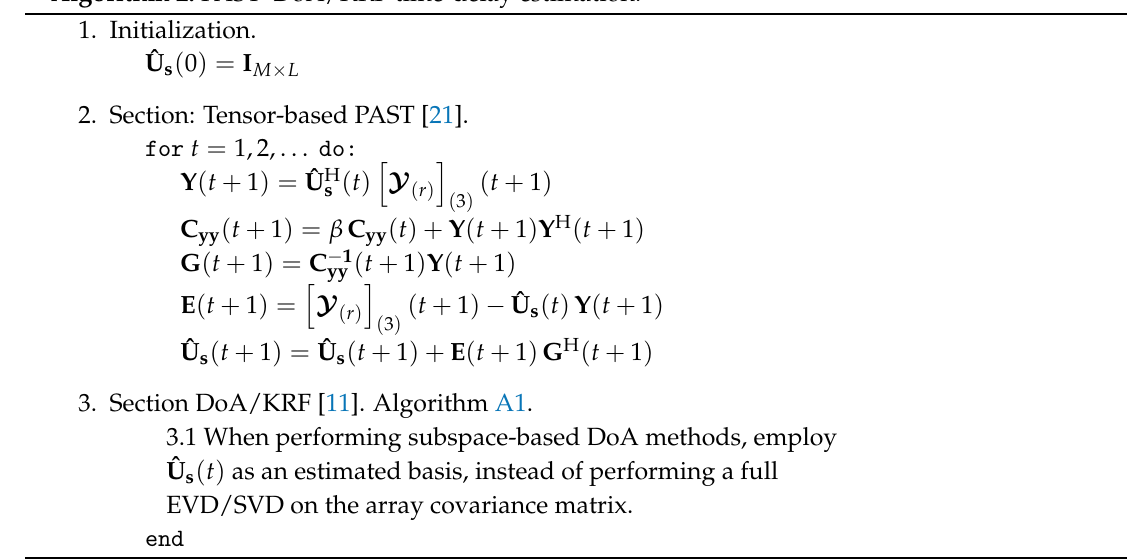
Algorithm 2: PAST–DoA/KRF time-delay estimation.